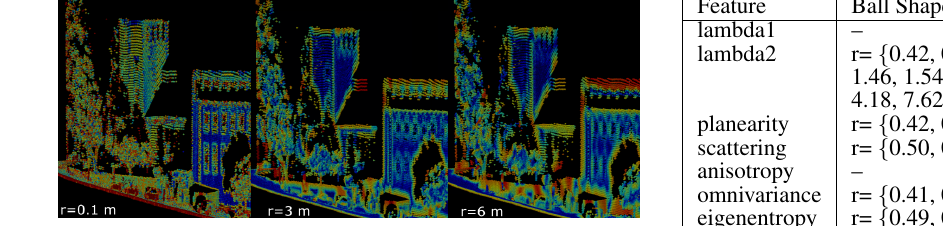
Figure 4. Points coloured by linearity values in different scales: 0.1, 2 and 3, from left to right; (Red: 1, Blue: 0)